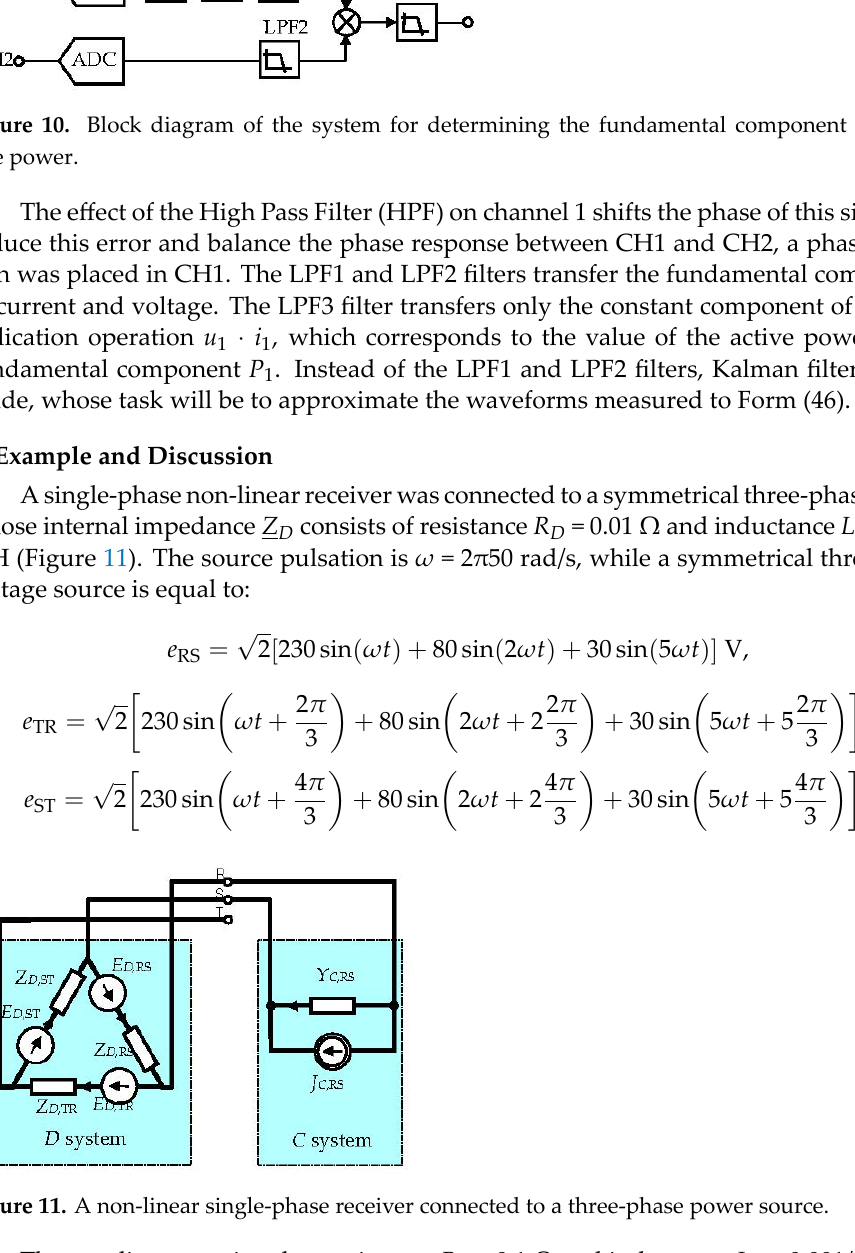
Figure 10. Block diagram of the system for determining the fundamental component of the active power.